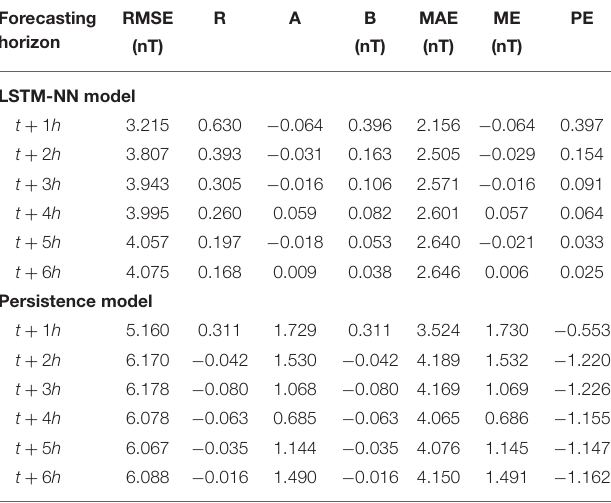
TABLE 6 | The DTW measure of the LSTM-NN model forecasting the 1 Dst. Forecast